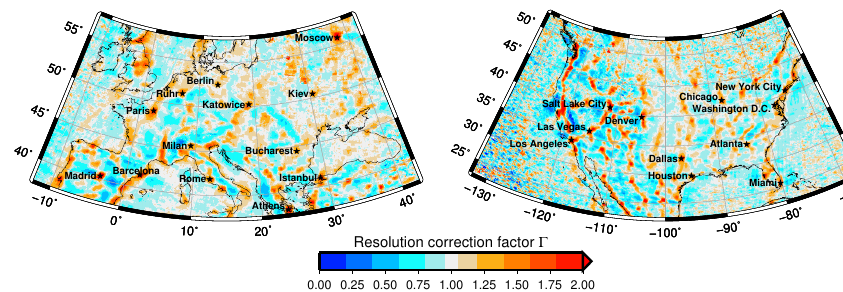
Fig. 6. Annual mean ¯Γ of the resolution correction factor over the United States (right) and Europe (left).